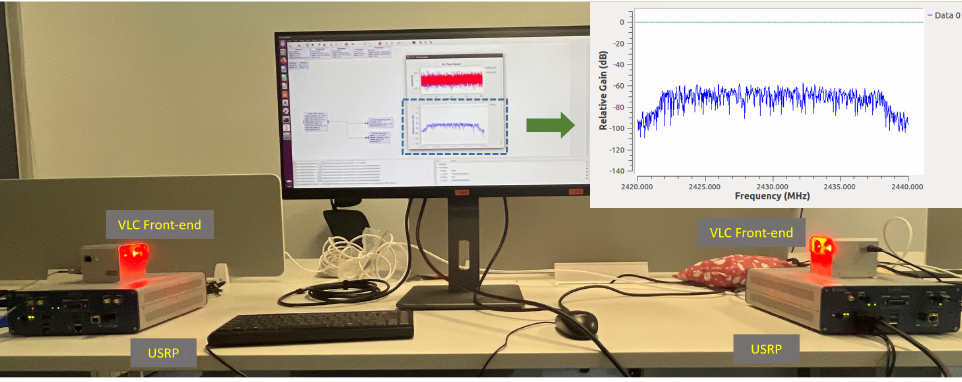
Figure 5. Hardware implementation used in our prototype of DP-VLC. The distance between the two optical front ends is 1.5 m. Personal computers used for training and signal processing are not shown